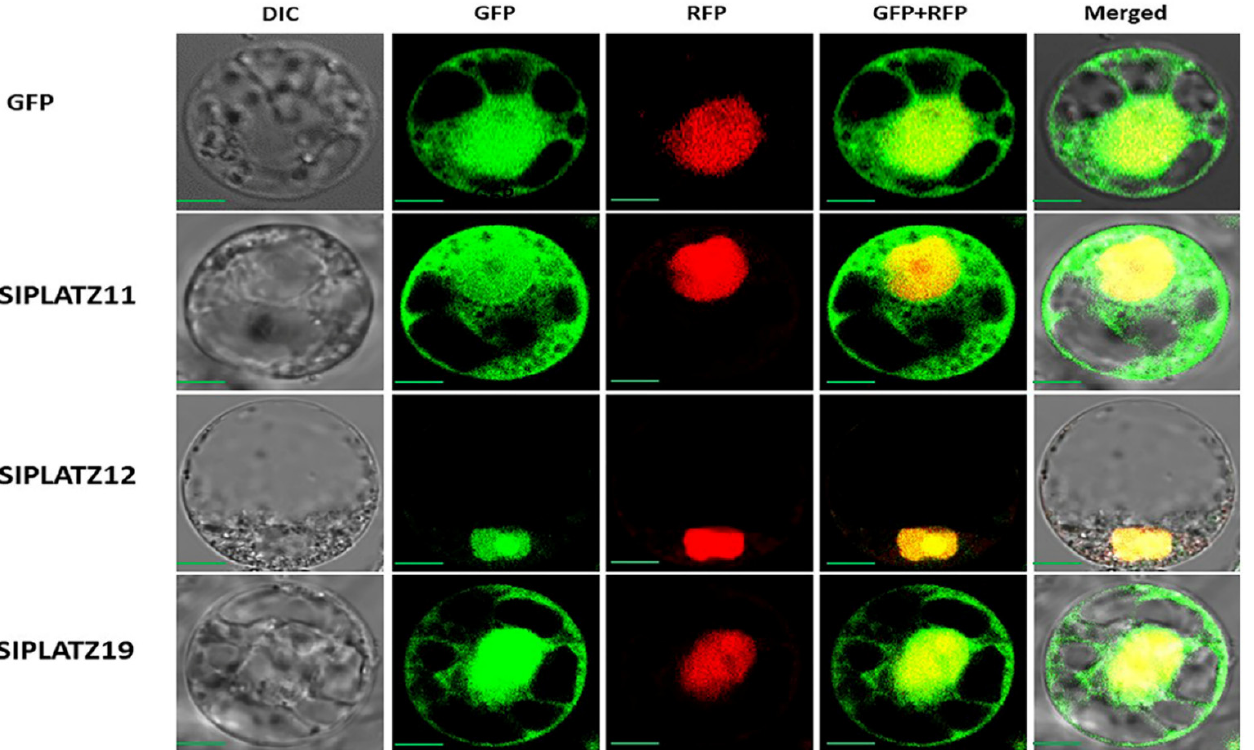
Figure 10. Subcellular localization analysis of SlPLATZ11, SlPLATZ12, and SlPLATZ19 by transiently expressing the SlPLATZs–GFP fusion constructs in Oc cell protoplasts. The NLS-mRFP construct served as a control for a nuclear protein. Scale bars = 100 μ m.